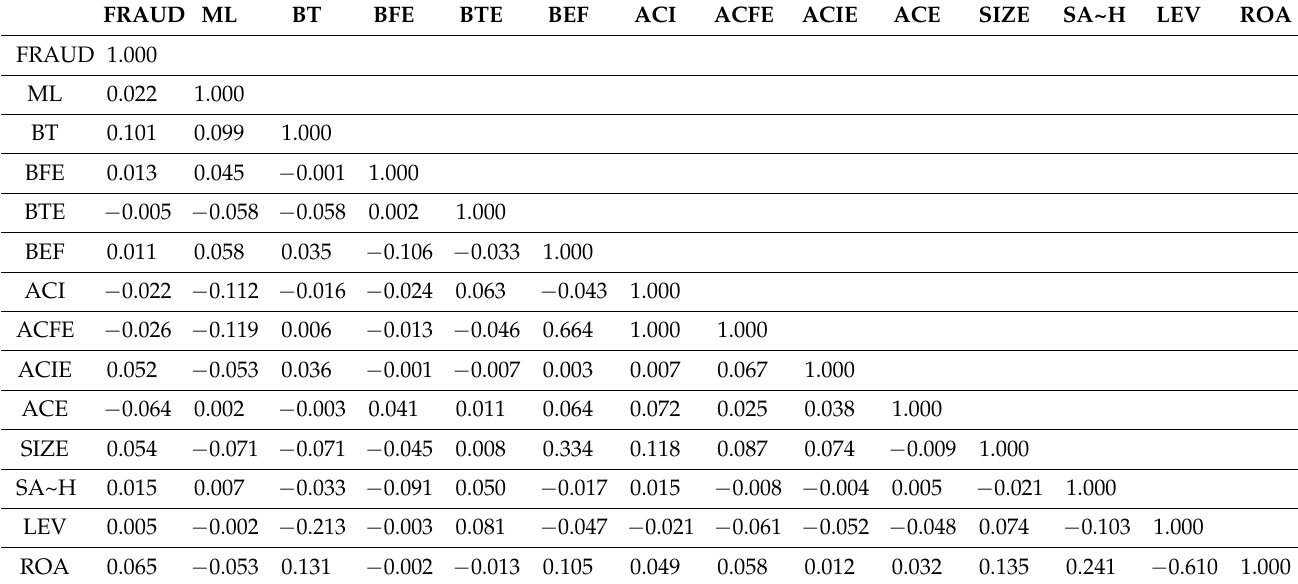
Table 10. Results of the correlation matrix of research